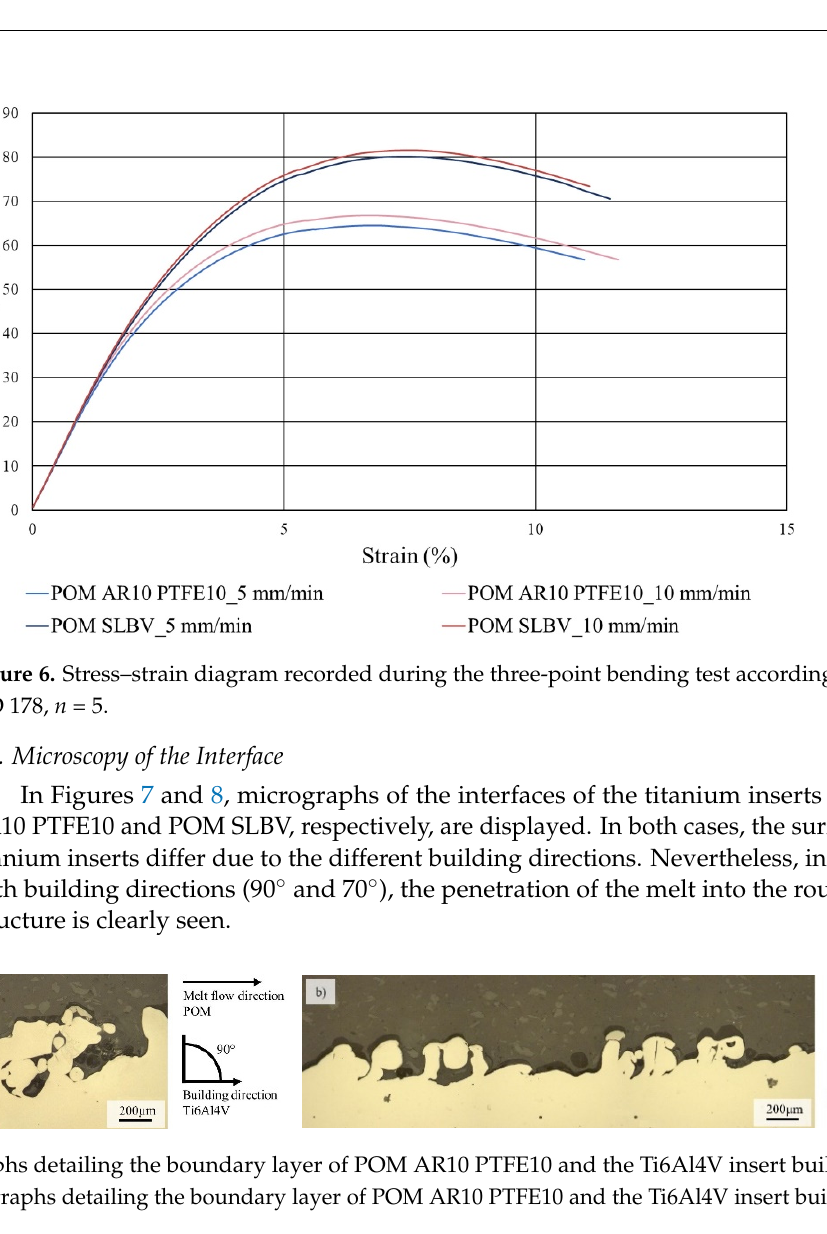
Figure 5. Stress–strain diagram recorded during the tensile test according to DIN EN ISO 527-2 (type